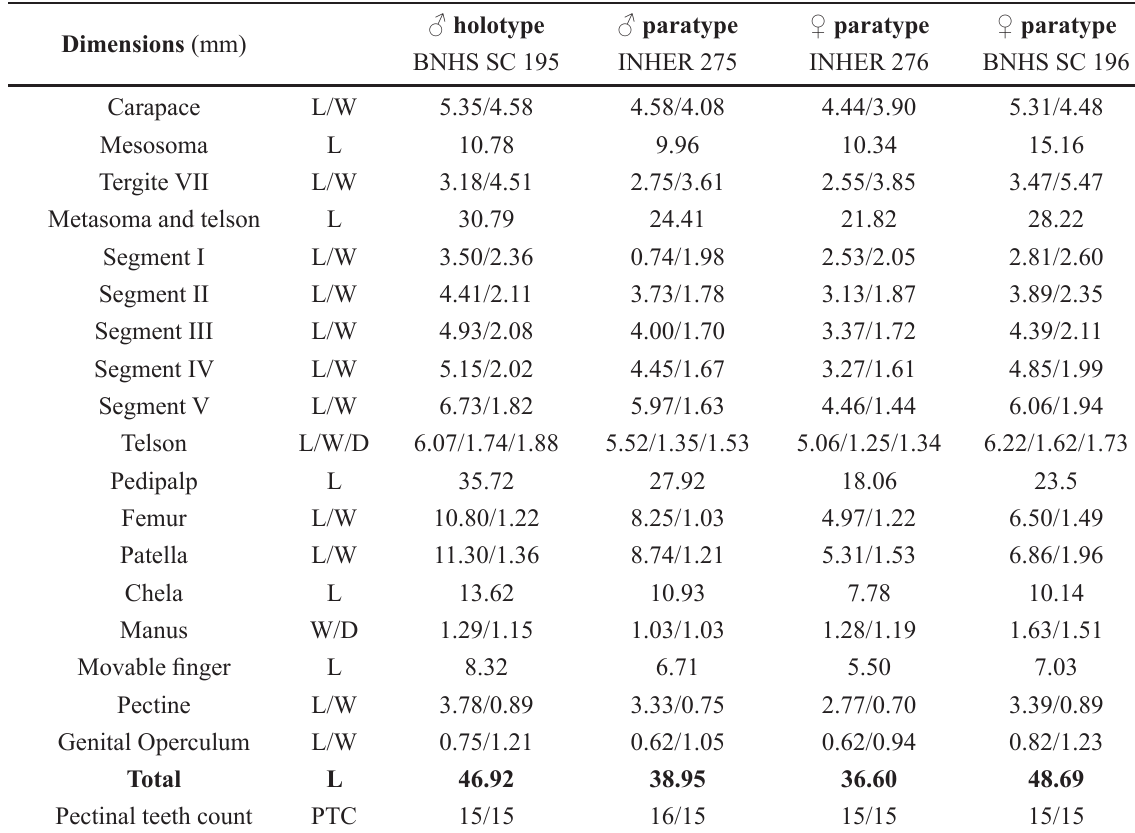
Table 2. Morphometric data for Isometrus nakshatra sp. nov. Abbreviations: L = length; W = width (in carapace corresponding to median width); D =